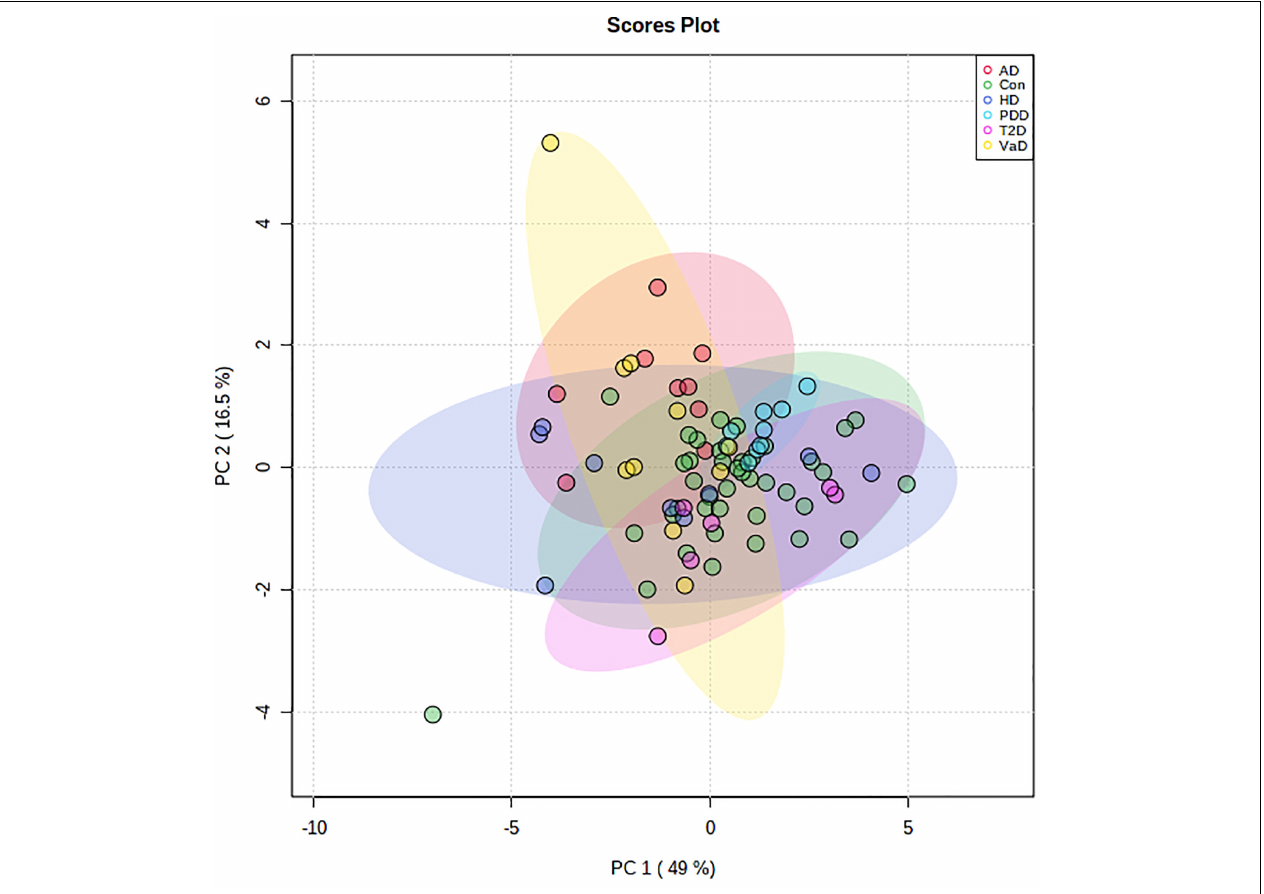
FIGURE 3 | Two-dimensional PCA plot for human dry-weight hippocampal post-mortem tissue from multiple age-related demented diseases and T2D. Data represents a PCA plot using ICP-MS-metallomic data from VaD ( n = 10; yellow), AD ( n = 9; red), HD ( n = 9; purple), PDD ( n = 9; blue), T2D ( n = 6; pink), and control ( n = 40; green) dry-weight hippocampal post-mortem tissue. The colored ellipses around each cohort signify 95% confidence regions. The first (Dim1) and second (Dim2) principal components contribute to 49 and 16.5% of the total variance, respectively. No visible separation is apparent between all cohorts. n = number of post-mortem human samples. AD, Alzheimer’s disease; Con, Control; ICP-MS, Inductively coupled plasma-mass spectrometry; PDD, Parkinson’s disease dementia; T2D, Type-2 diabetes; VaD, Vascular